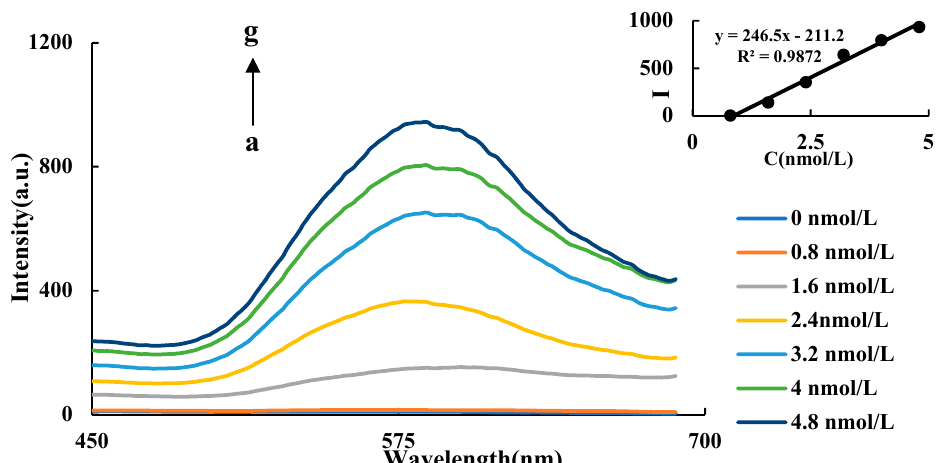
Figure 3. RRS spectra of CuNCs catalysis a: 4.2 µ mol/LHAuCl4 + 3.5 mol/L ethanol + 0.5 mol/LHCl; b: a + 0.8 nmol/L CuNCs; c: a + 1.6 nmol/L CuNCs; d: a + 2.4 nmol/L CuNCs; e: a + 3.2 nmol/L CuNCs; f: a + 4 nmol/L CuNCs; g: a + 4.8 nmol/L CuNCs.